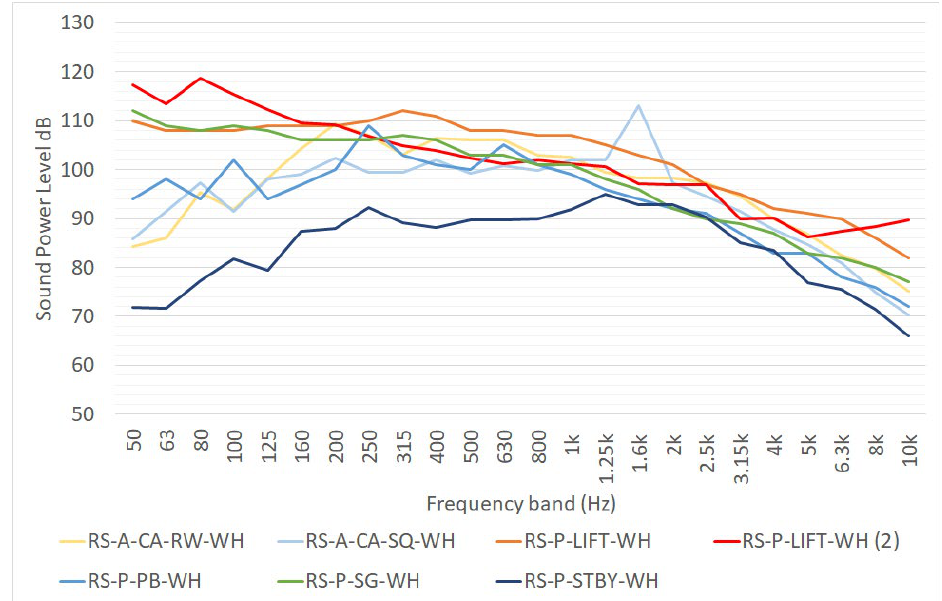
Figure 3. One-third octave sound power level spectra of a reach stacker, as reported in [16–18,36]. L W is expressed in dB for point sources, in dB/m for linear sources and in dB/m 2 for area sources. RS-A-CA-RW-WH, RS-A-CA-SQ-WH and RS-P-STBY-WH data are taken from [16], RS-P-LIFT-WH, RS-P-PB-WH and RS-P-SG-WH from [18], RS-P-LIFT-WH (2) from